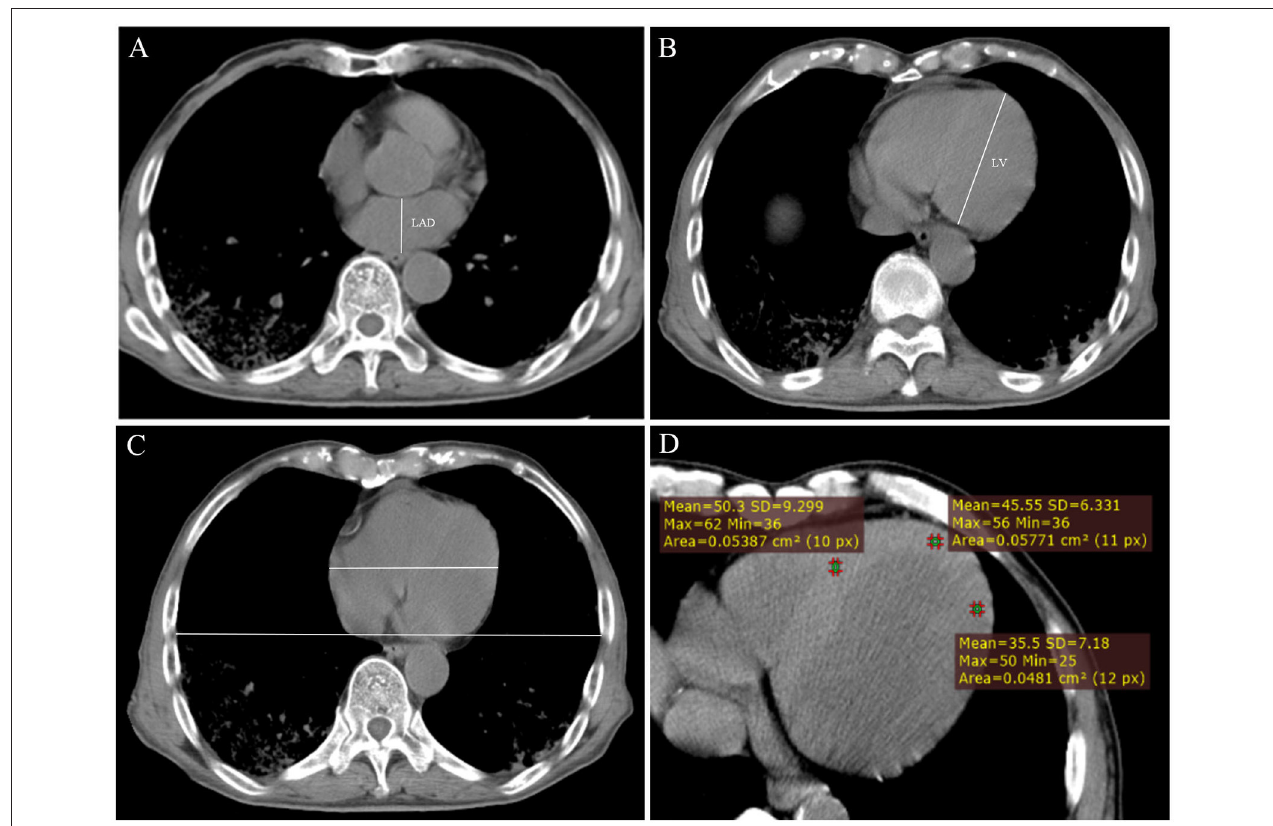
FIGURE 2 | (A) Measurement of the anteroposterior diameter of the left atrium (LAD). (B) Measurement of the length of the left ventricle (LV). (C) Measurement of cardiothoracic ratio. (D) Measurement of CT value of myocardium at axial image.